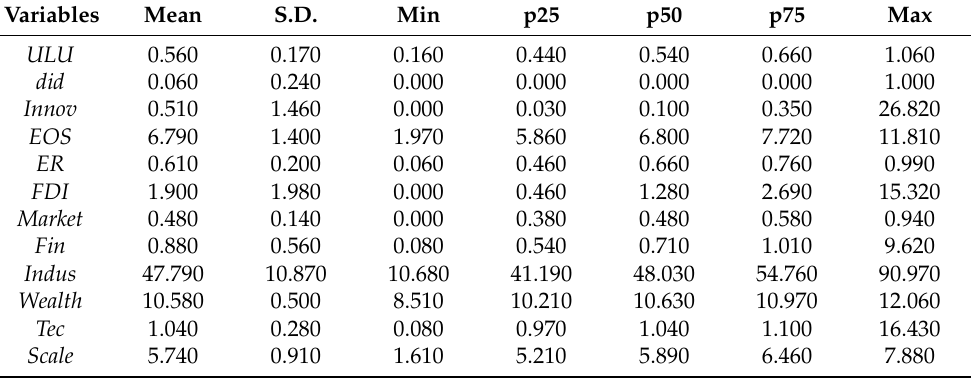
Table 3. Data descriptive